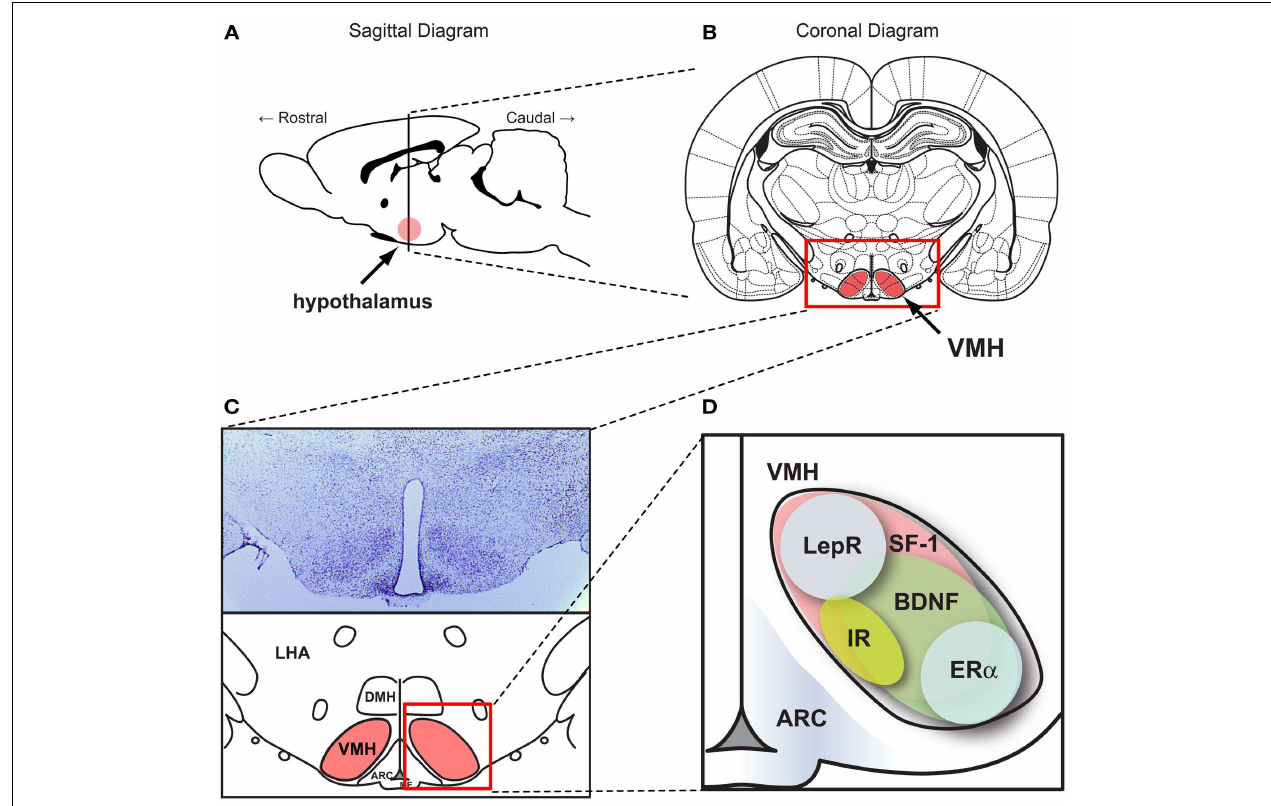
arcuate nucleus. DMH, dorsomedial hypothalamic nucleus. LHA, lateral hypothalamic area.VMH, ventral medial nucleus of the hypothalamus. BDNF, brain-derived neurotrophic factor. ER α , estrogen receptor alpha. IR, insulin receptors. LepR, leptin receptors. SF-1, steroidogenic factor-1. Schematic diagrams were generated based on data from McClellan et al. (2006) andYi et al.